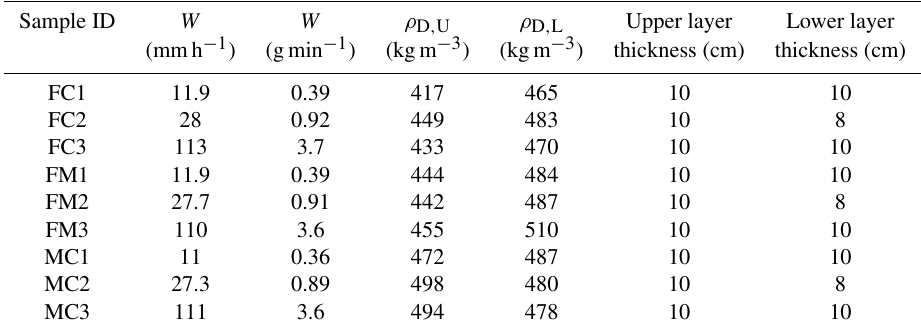
Table 1. Experimental details: W is the applied water input rate, ρ D , U is the dry density of the upper layer, and ρ D , L is the dry density of the lower